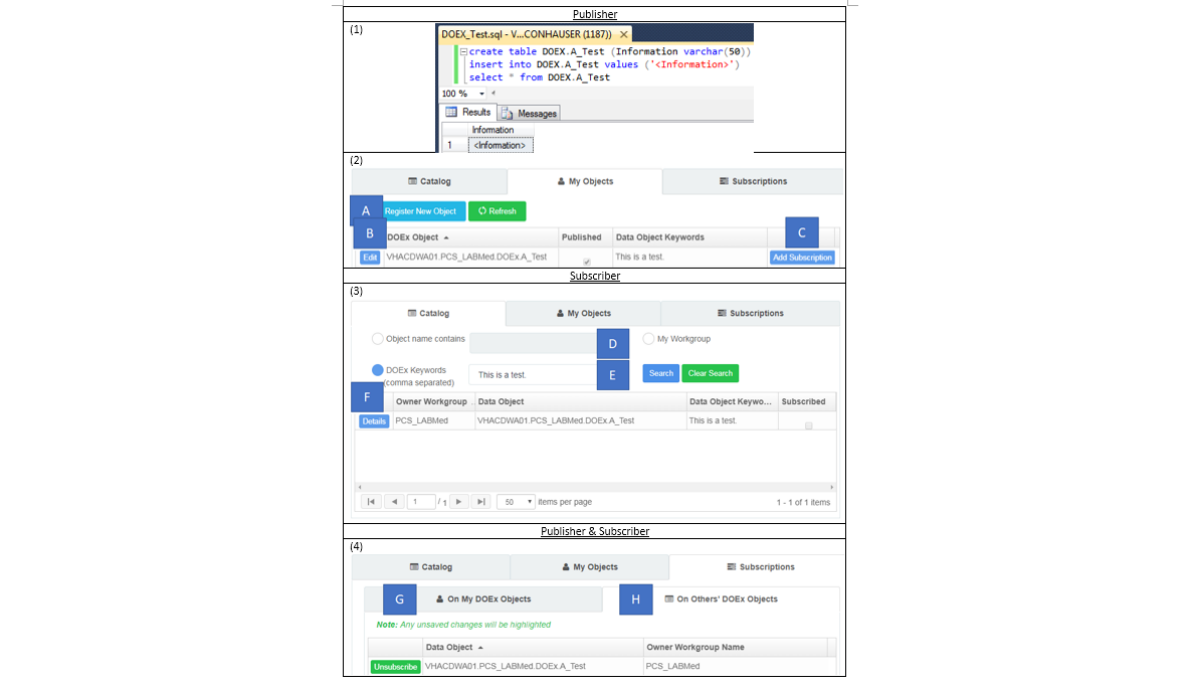
Figure 2. Data Object Exchange (DOEx) web interface. (1) The publisher creates a database object. Example provided in Microsoft SQL Server.